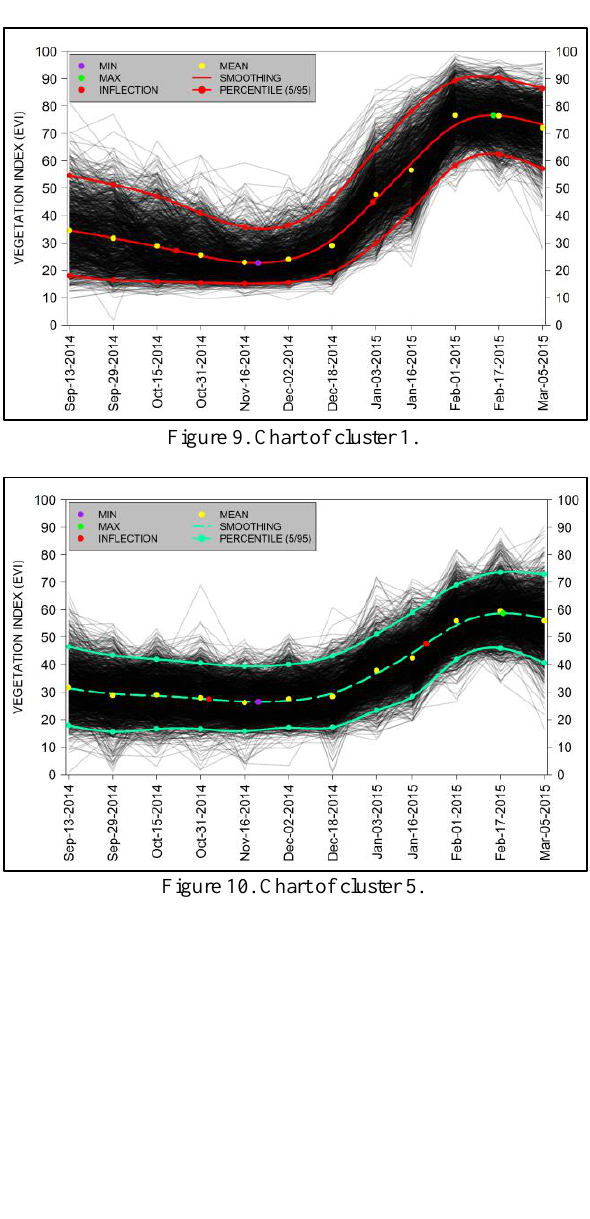
Figure 8. Average EVI phenological firms of clusters.